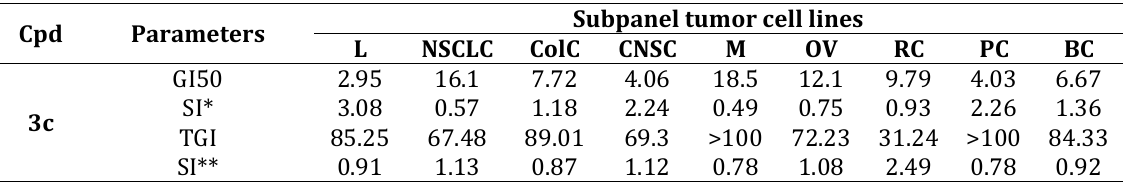
Table III. Anticancer selectivity pattern of the most active compound 3c at the GI 50 (С, μМ) and TGI (С, μМ) levels